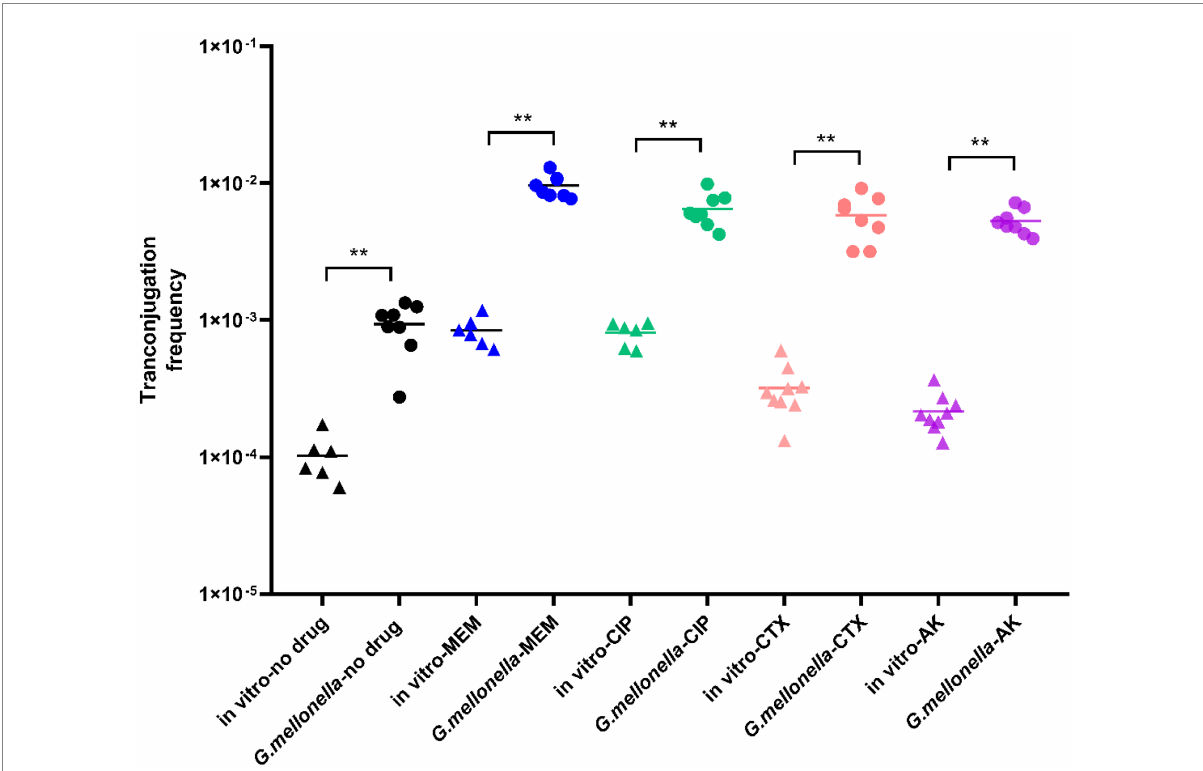
FIGURE 4 Conjugation frequency in G . mellonella . For comparison, in vitro transconjugation frequencies are shown. The stars indicate statistical significance at different levels: * P < 0.05, ** P <